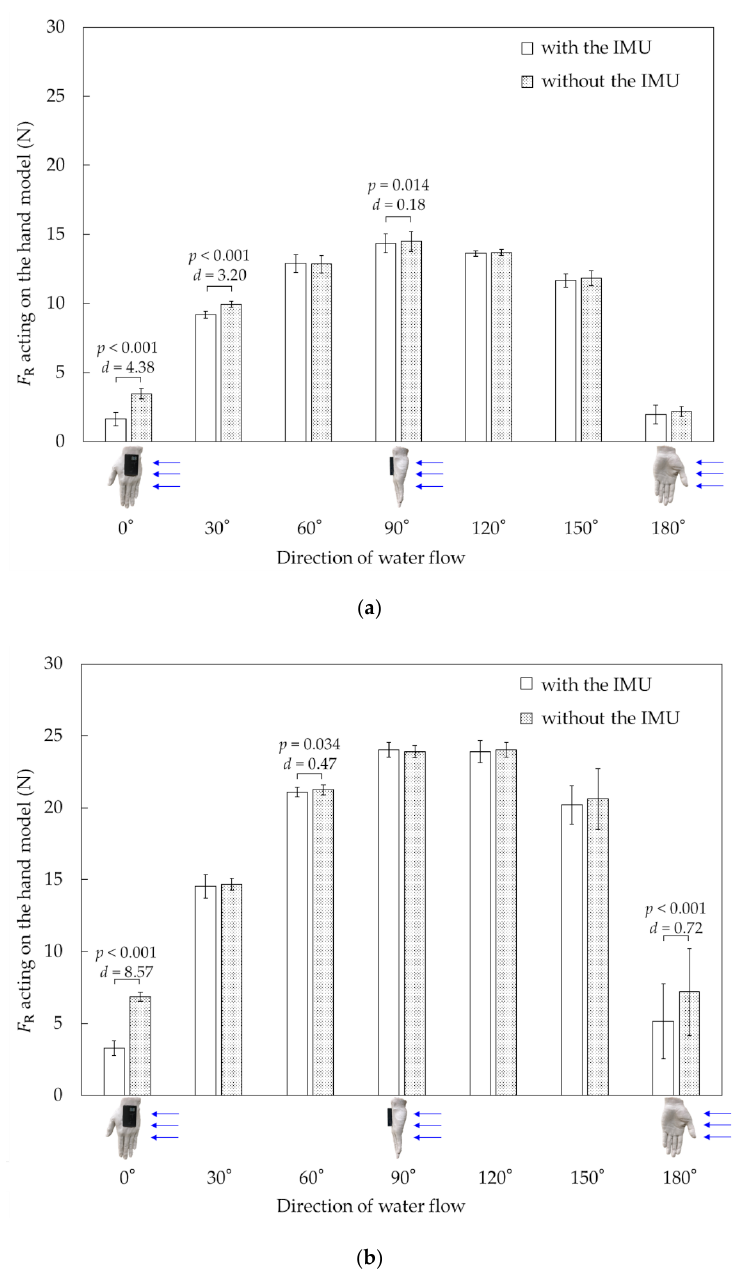
Figure 7. Variation in resultant force with and without IMU with variations in flow velocity and water flow direction. ( a ) Flow velocity = 1.2 m·s − 1 ; ( b ) flow velocity = 1.6 m·s − 1 .